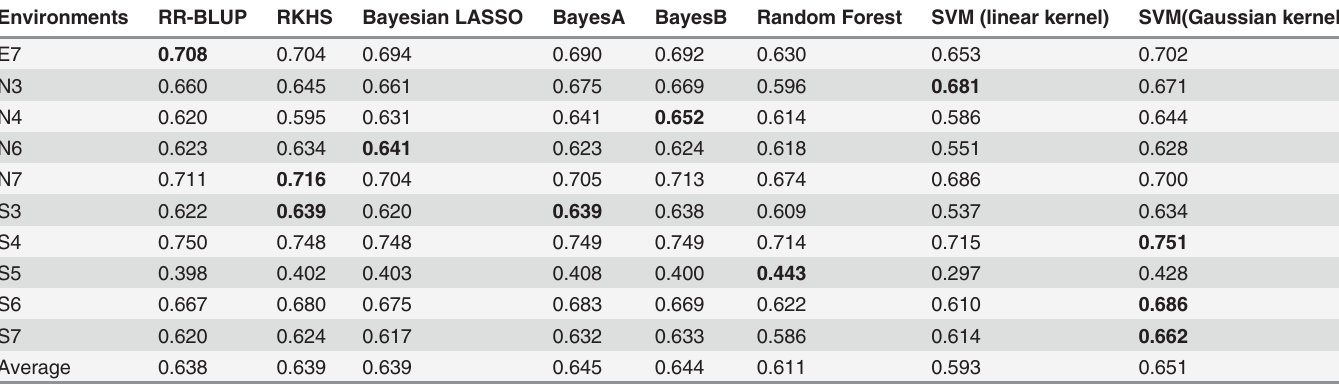
The best prediction model for each environment in the data set is in bold. The performance was evaluated via 10 runs of 10-fold cross-validation and the prediction accuracy was the mean Pearson correlation coef fi cients of predicted and observed FT. Finally, for further association study, genomic estimated breeding values (GEBVs) were predicted for each geographic region using RKHS with year as a covariate, respectively. RKHS implemented in the R package ‘ rrBLUP ’ is capable of handling multiple